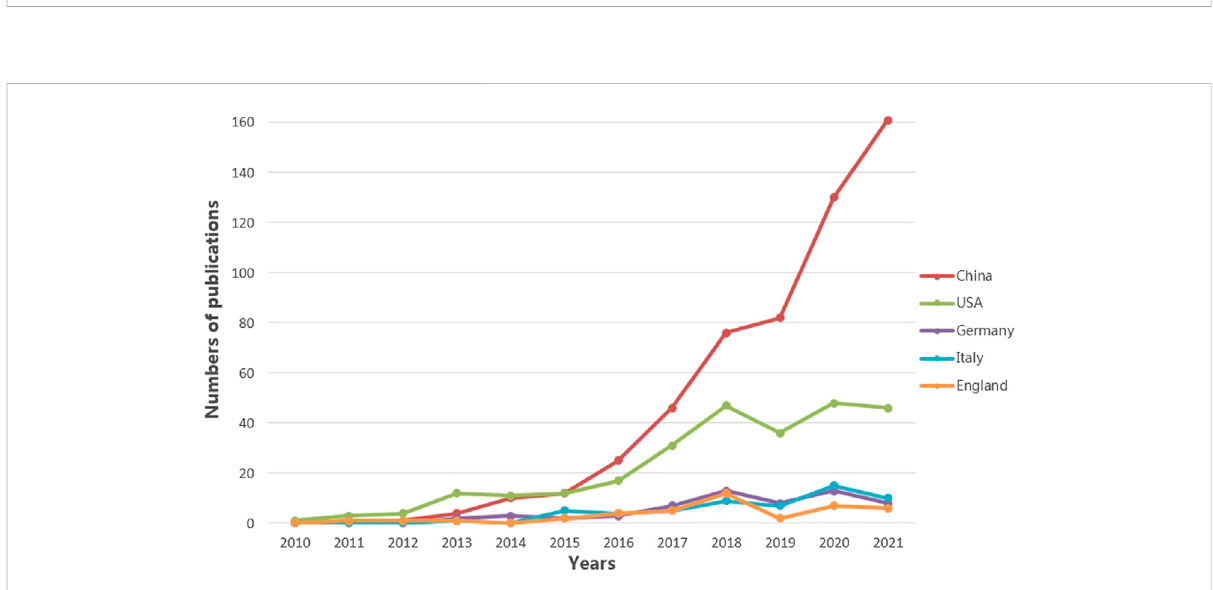
FIGURE 4 Annual number of publications over countries. The fi ve countries with the highest number of published articles are China, the United States, Germany, Italy, and England. The annual number of publications from these fi ve countries is illustrated. The different color lines represent different